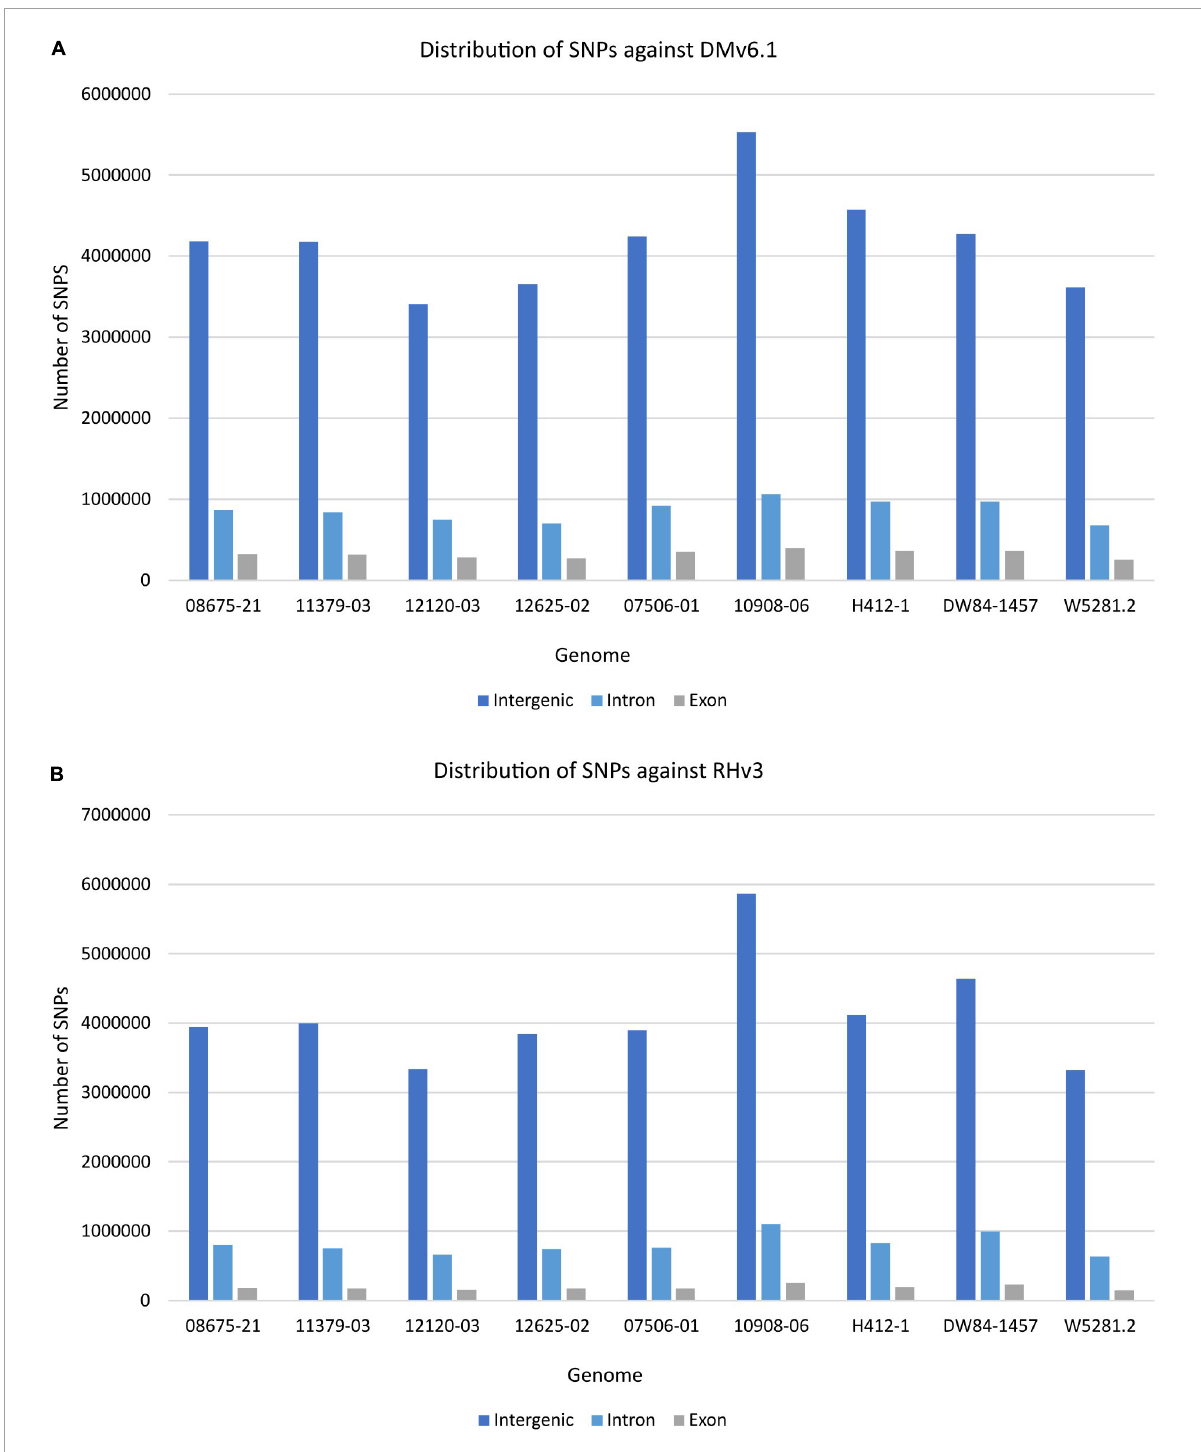
FIGURE1 Distribution of SNPs in each genome in the intergenic, intron, and exon regions when compared against (A) DMv6.1 and (B) RHv3.